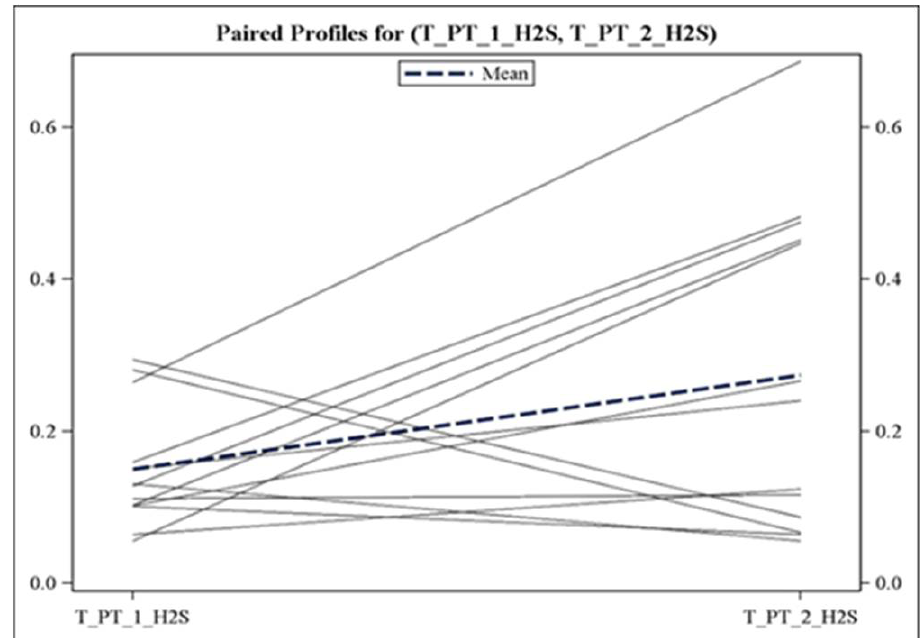
Figure 1. Individual trajectories of H 2 S concentration in patients with OSA. H 2 S levels (in μM) were analyzed at baseline (before sleep, T_PT_1) and at the time of OSA diagnosis (T_PT_2). Data from patients with baseline H 2 S of >0.5 μM ( n = 4) were not included.